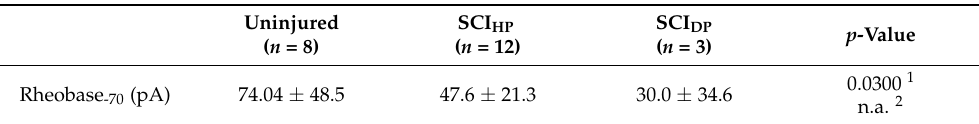
lower than that of uninjured neurons. * p < 0.05; *** p < 0.0001. Table 4. Rheobase of M1LV neurons measured from equalized membrane voltage ( − 70 mV), in presence of effects were minor. Notably, the application of ZD7288 did not elicit RMP